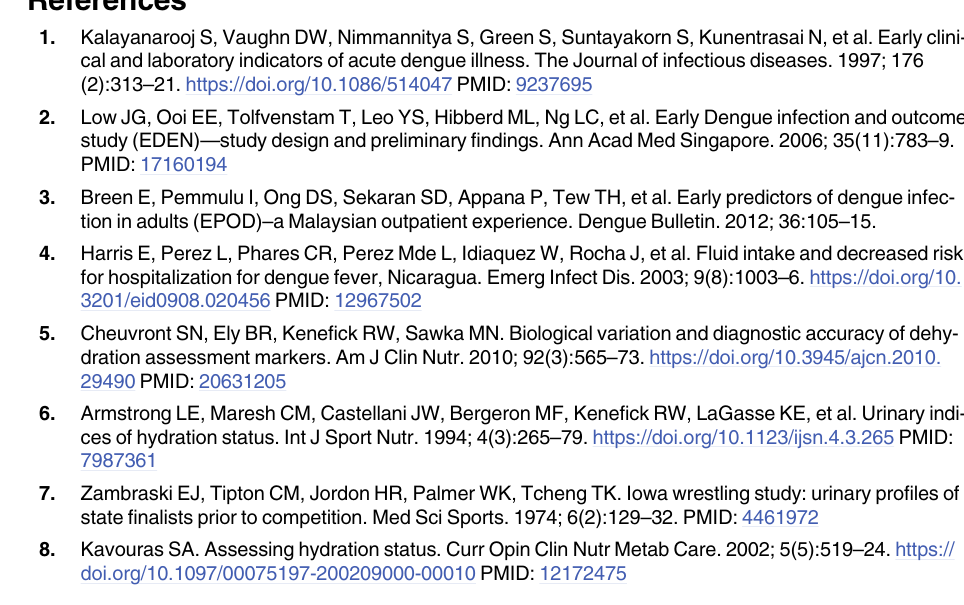
S1 Table. Spearman correlation analysis between urine biochemical